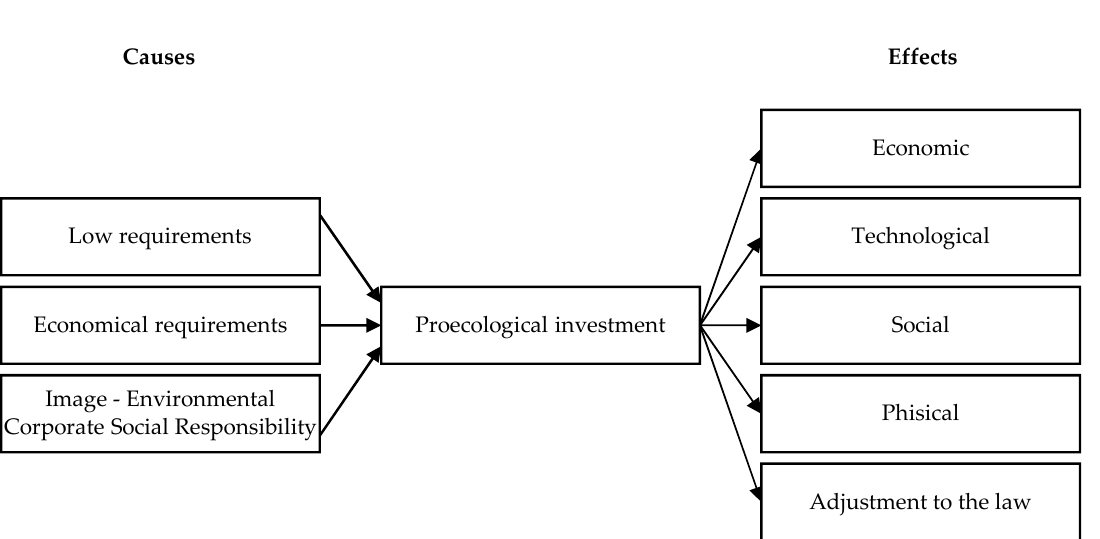
Figure 4. Cause–effect model of pro-ecological